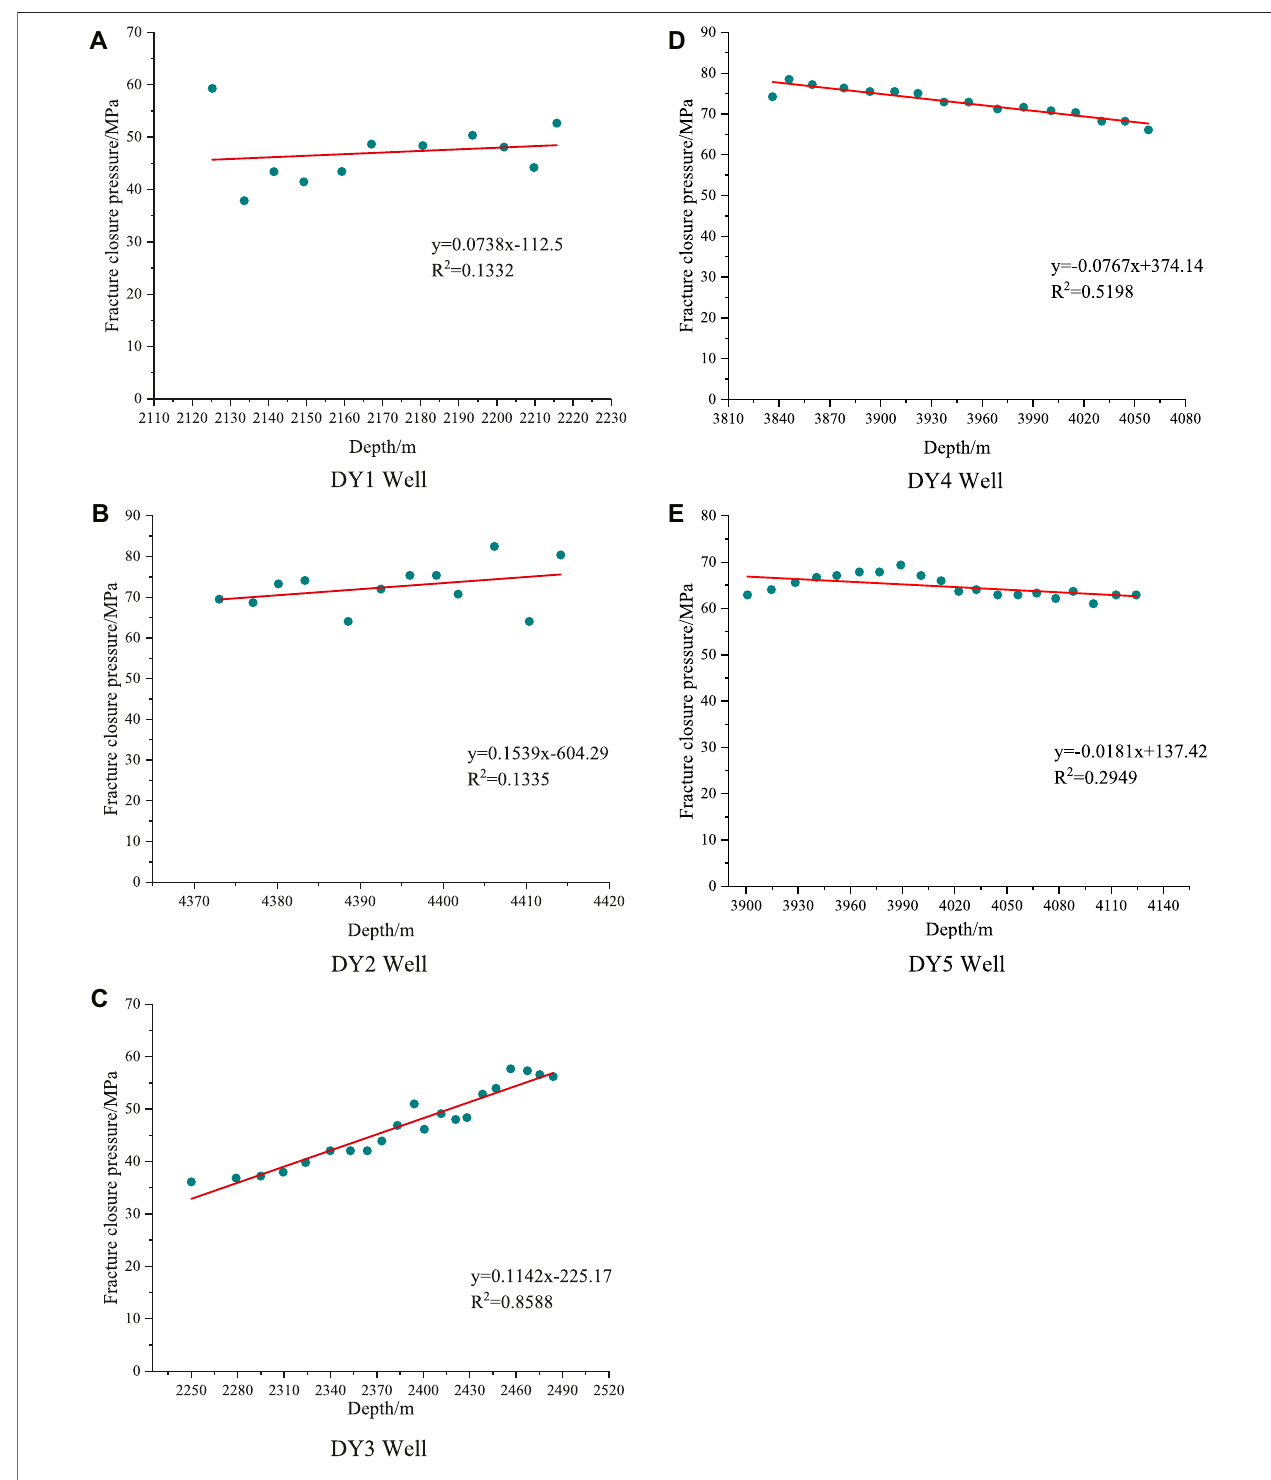
FIGURE 6 | Relationship between fracture closure pressure and depth in Dingshan area. (A) DY1 Well. (B) DY2 Well. (C) DY3 Well. (D) DY4 Well. (E) DY5 Well.